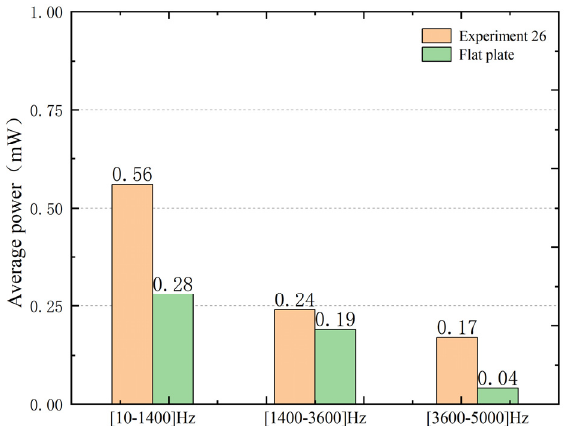
Figure 14. The output average power of the flat plate VEH and Experiment 26 VEH under different frequency regions.